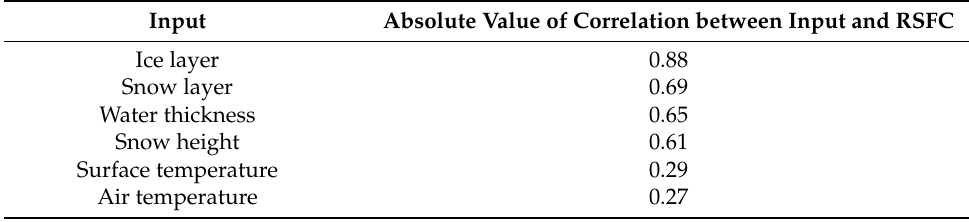
Table 2. Pearson correlation coefficients between input variables and RSFC.